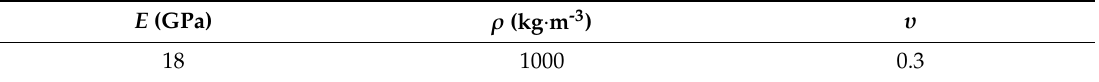
Table 3. Mechanical properties of rubber gasket